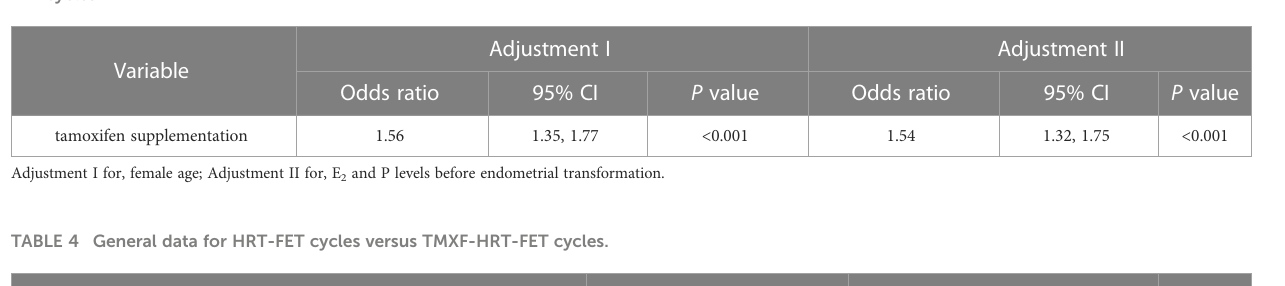
TABLE 3 Multivariate analysis for the effect of tamoxifen supplementation on the change in endometrial thickness between TMXF-HRT cycles and last FET cycles.